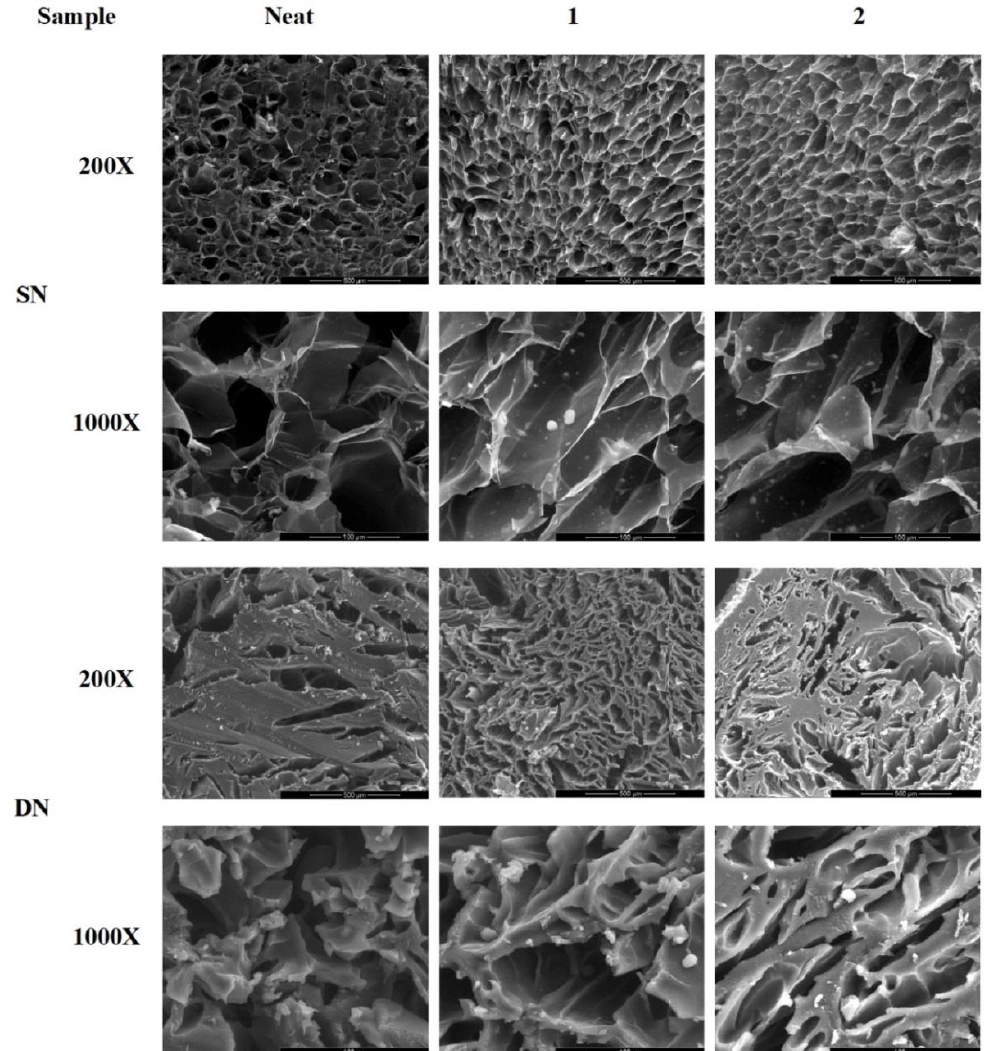
Figure 4. Representative scanning electron microscopy (SEM) images of: SN and DN hydrogels and related nanocomposites at different magnifications (200× and 1000×).